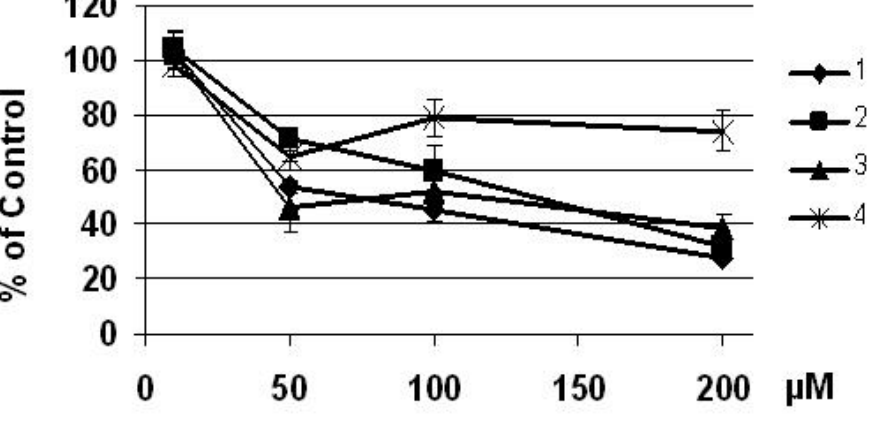
Figure 2. Effects of chalcones on the growth of HepG2 hepatome cells after 24 h Incubation. The results of studies are expressed as mean values ±SD from three separate experiments